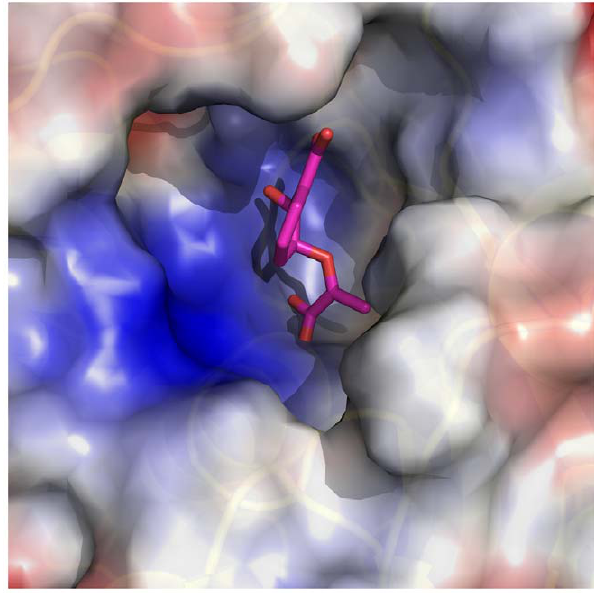
Figure 3. Isochorismatase from B.thailandensis . The isochorisma- tase family protein (BTH_II2229, PDB: 3TXY) from B. thailandensis , is shown in electrostatics surface representation with bound isochor- ismate taken from the P. aeruginosa ischorismatase, PhzD (PDB: 1NF8). 3TXY and 1NF8 have 30% sequence identity and an overall C a RMSD of 1.7 A˚. By aligning 1NF8 and 3TXY, the active site of 3TXY can be identified as a large pocket with a combination of hydrophobic (white) and positively charged (blue) amino acid residues.